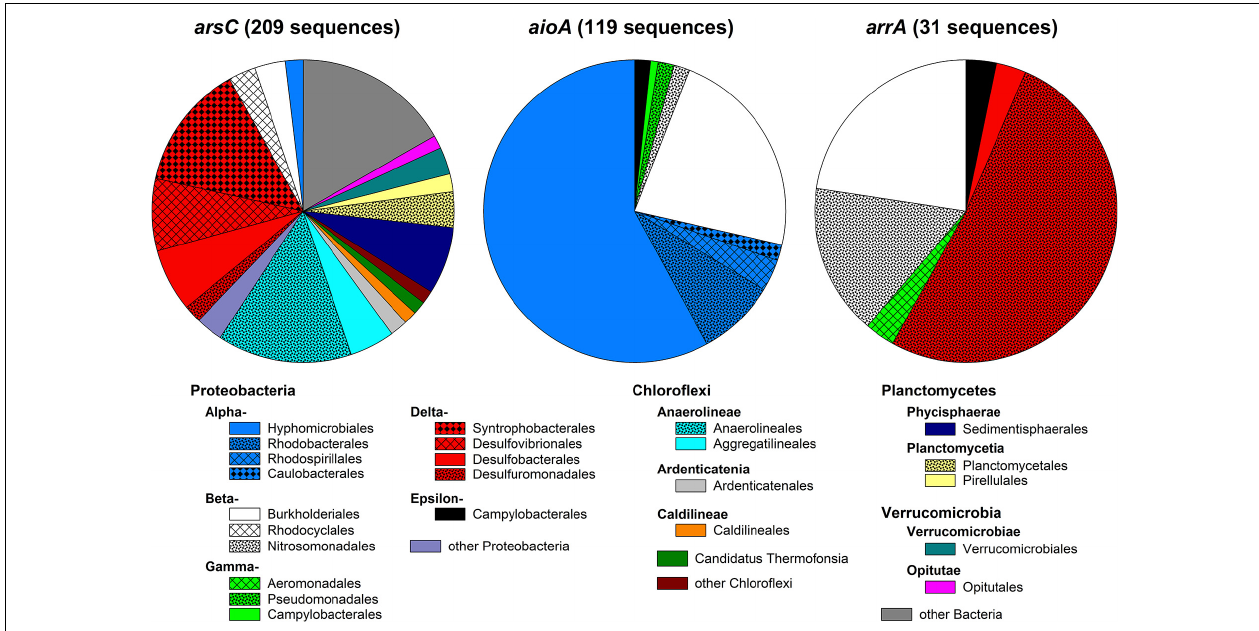
FIGURE 9 | Order-level diversity of functional genes involved in arsenic metabolism in peat. Metagenomic reads were searched against custom databases for arsC (encoding the detoxifying arsenate reductase), aioA (encoding the arsenite oxidase), and arrA (encoding the dissimilatory arsenate reductase). Only matches with lengths ≥ 100 bp were